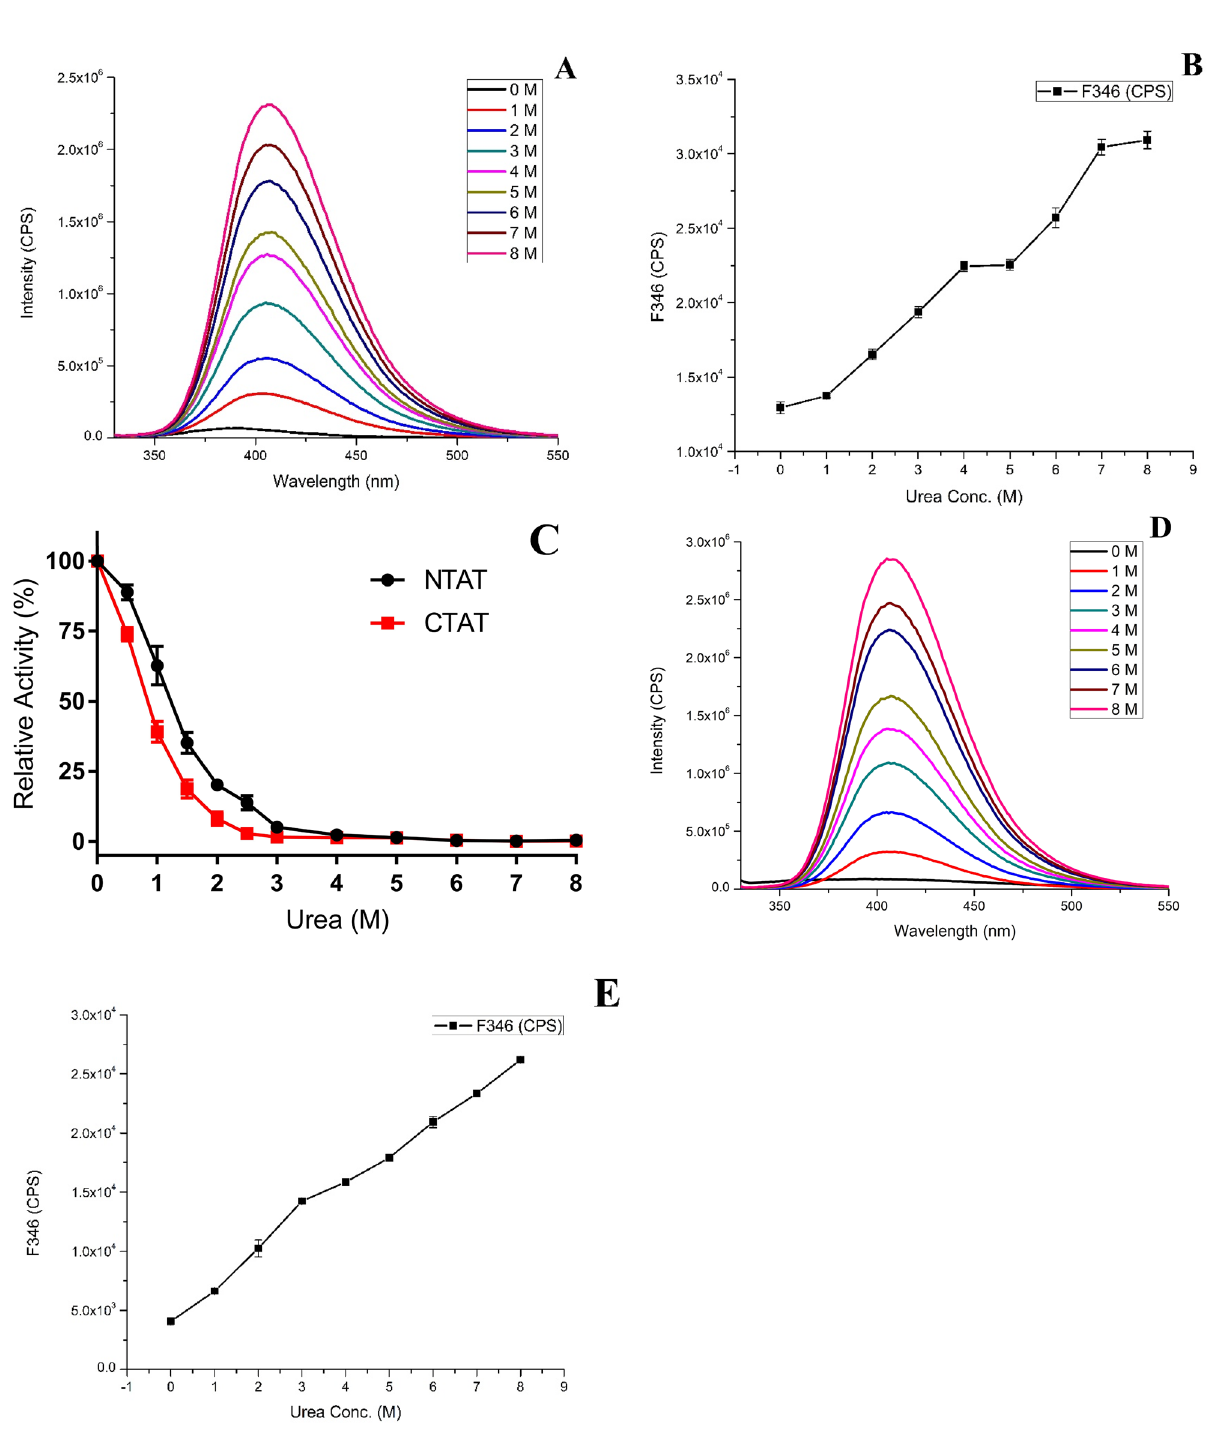
Figure 6. Urea denaturation and folding studies ( A ) and (D) Fluorescence intensity of NTAT and CTAT respectively measured at various urea concentrations. A steep increase in the intensity and redshift of emission maxima were observed in both the fluorescence plot. ( B ) and ( E ) The plot showing an increase in the fluorescence intensity of NTAT and CTAT respectively at 346 nm at increasing urea concentration. It is seen that NTAT exhibits N → X → D states with intermediate X state at 4–5 M urea while CTAT does not display any intermediate state of denaturation N → D (N-Native; D-Denatured). ( D ) Relative activity of NTAT (red) and CTAT (black) with increasing urea concentration was determined and NTAT showed activity till 2.5 M urea while CTAT became inactive at 2 M